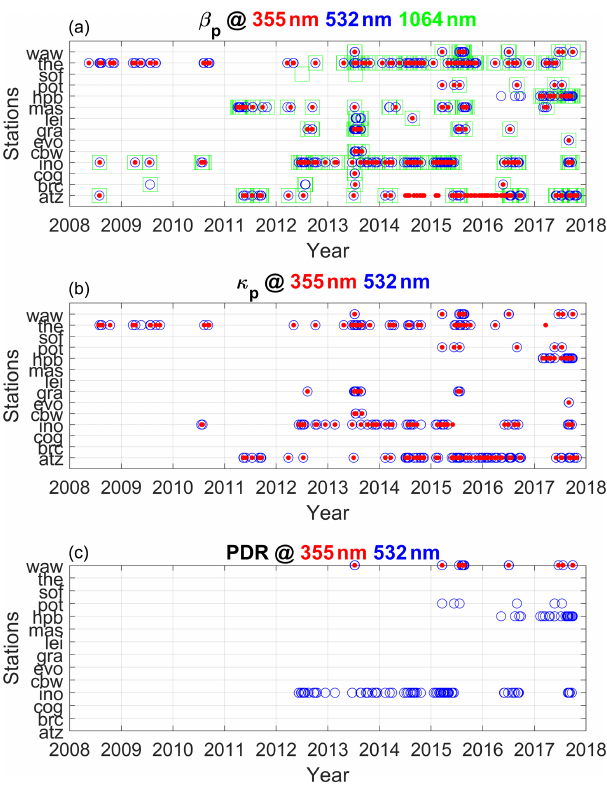
Figure 4. Time span of the available particle backscatter coeffi- cient (a) , extinction coefficient (b) , and depolarization ratio (c) for each station, over the 2008–2017 period, for the smoke